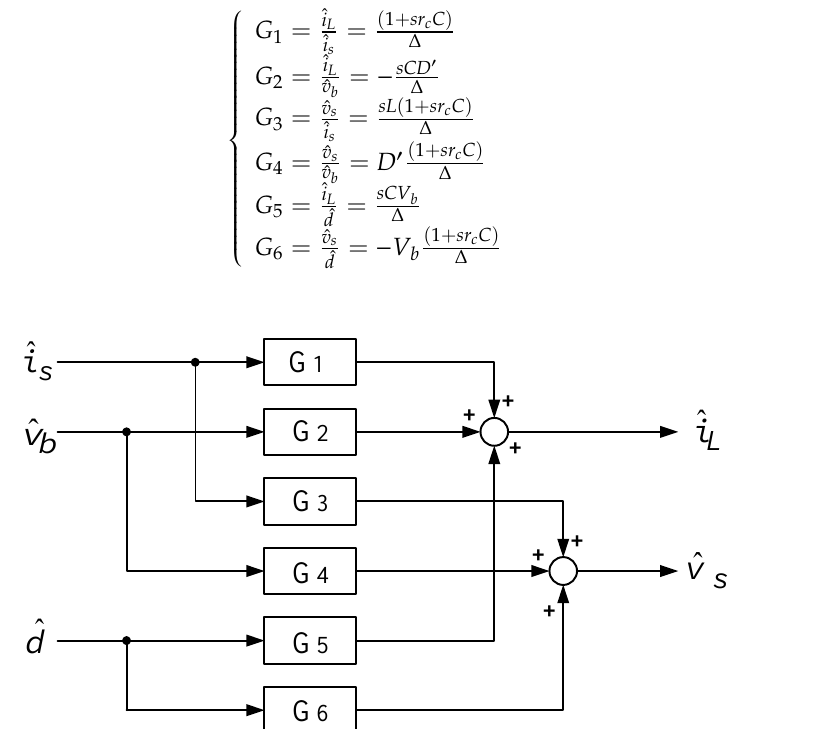
Figure 7. Small-signal block diagram of unterminated model.